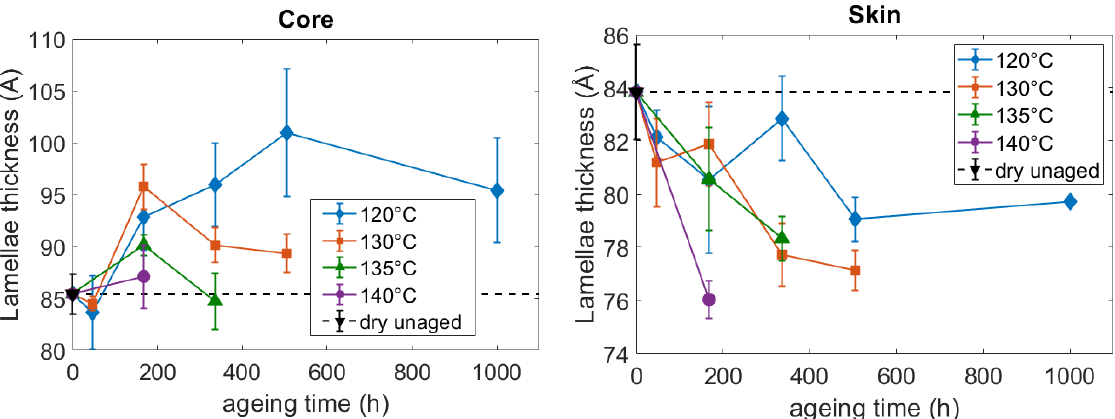
Figure 8. Influence of the aging conditions on the lamellae thickness at the core and the surface of the PA66 plaques.